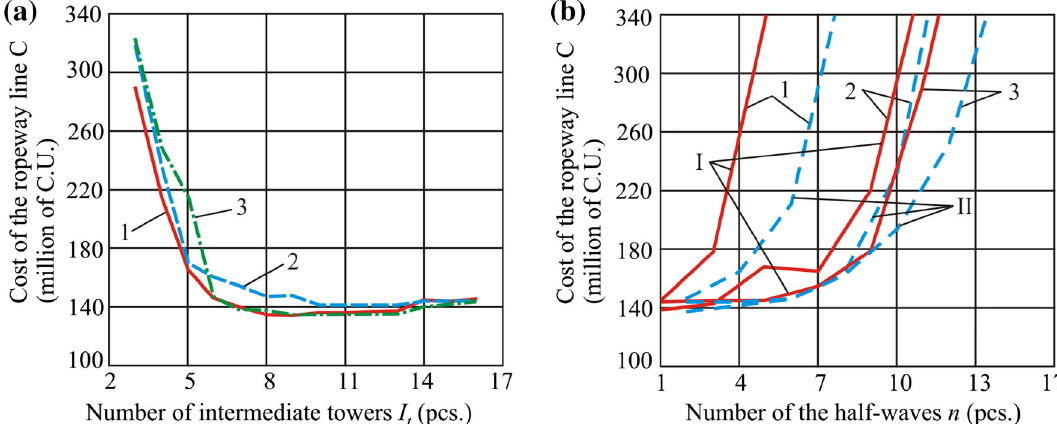
Fig. 5 Theinfluenceoftheterrainonthecostoftheaerialropewayline when the surface shape is sinusoidal: ( a ) height (1— V max = 50 m; 2—25 m; 3—0 m); ( b ) longitudinal variation (I—the odd number of